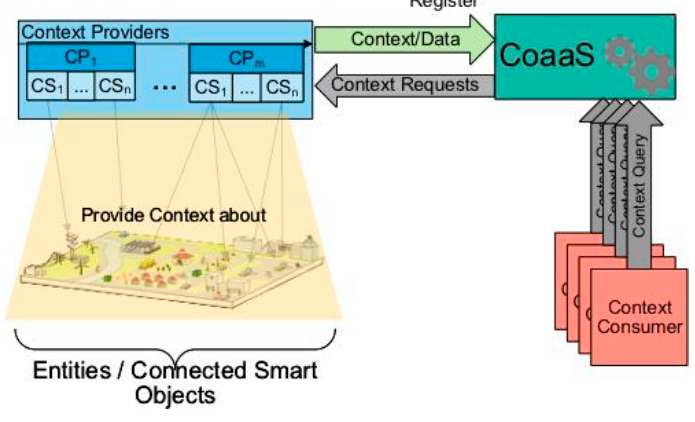
Figure 2. CoaaS big picture.